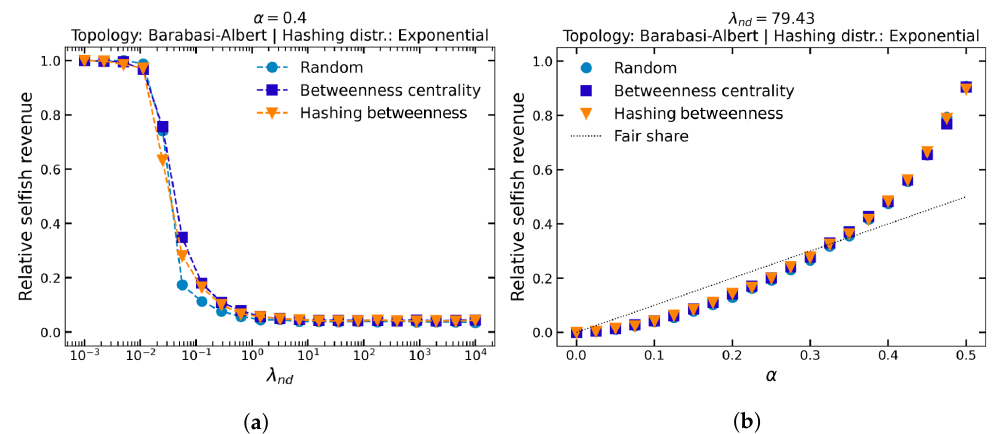
Figure 5. Relative selfish revenue as a function of: ( a ) latency ( λ nd ) and ( b ) selfish hashing power ( α ). Selfish miners are located according to various centrality measures.